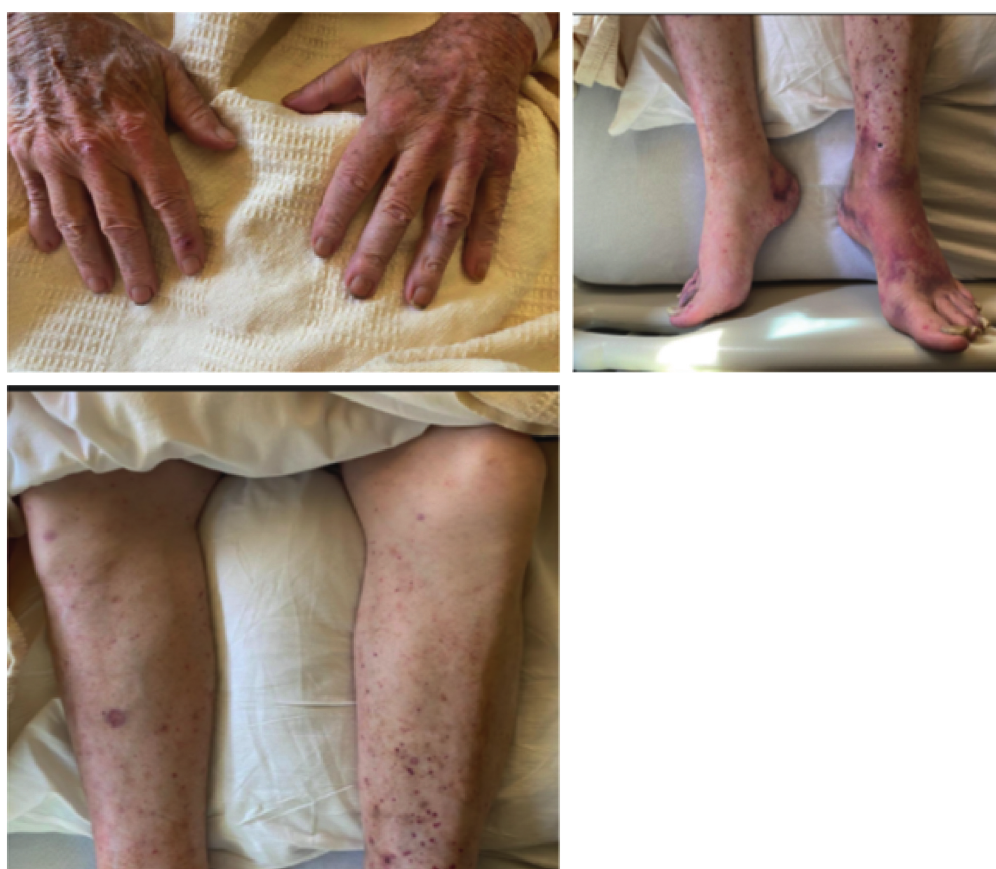
Figure 3: 3 days post-Solu-Medrol treatment with improvement in purpura and